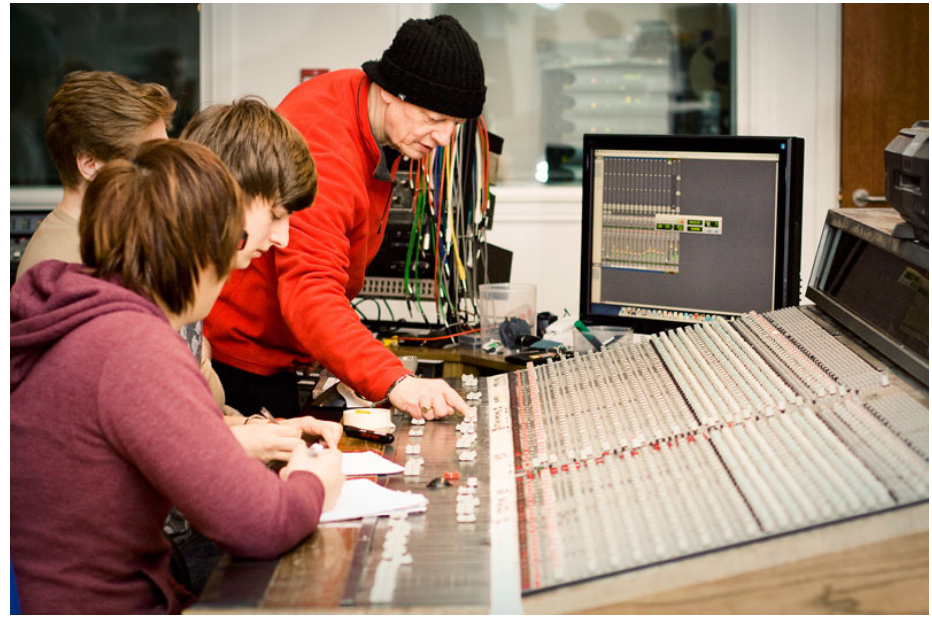
Figure 4. Sound production students studying at Riverside Studio